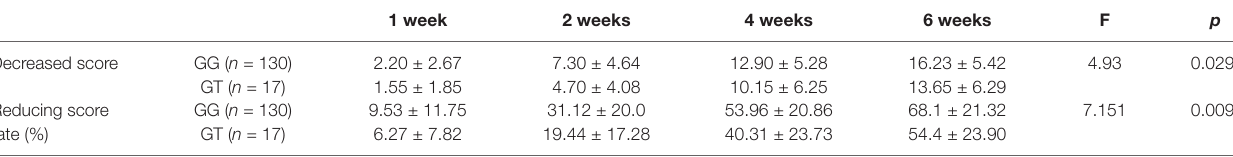
*Statistically significant difference between the groups (p < 0.05).